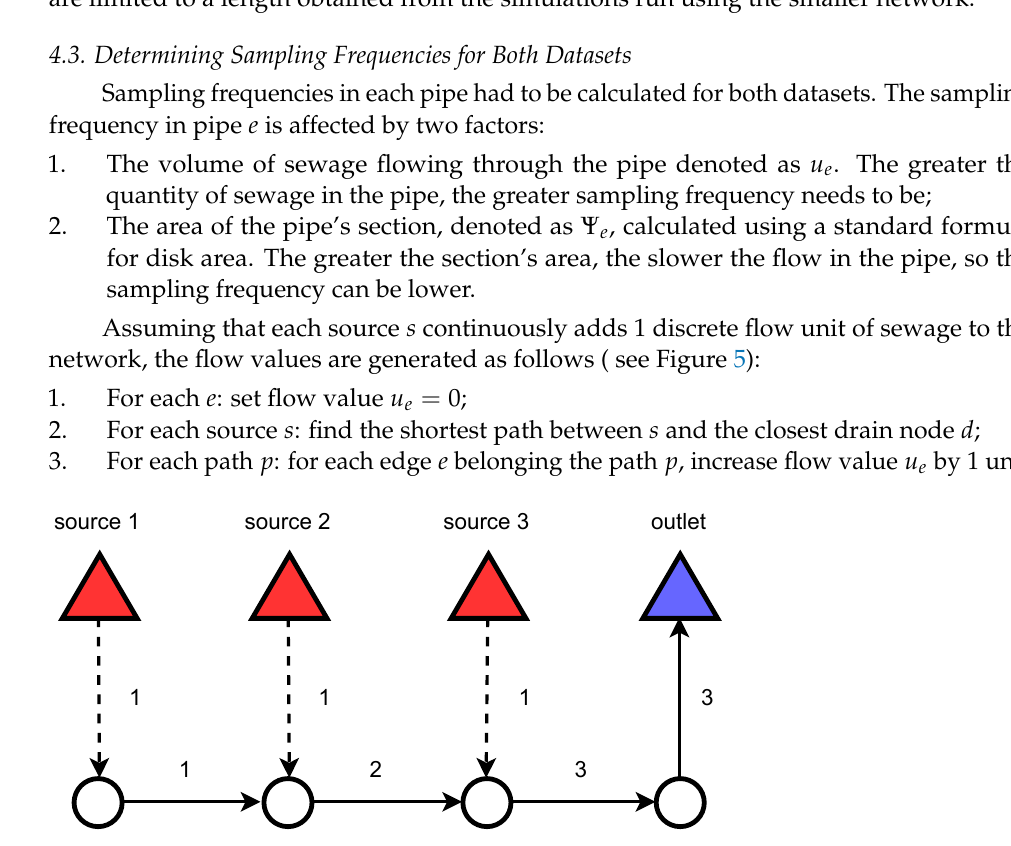
Figure 5. Flow units propagating through the network. The number over the edge is the number of flow units in the pipe. The greater number of flow units next to the outlet node means that a bigger volume of sewage flows in that part of the network when compared to pipes next to the